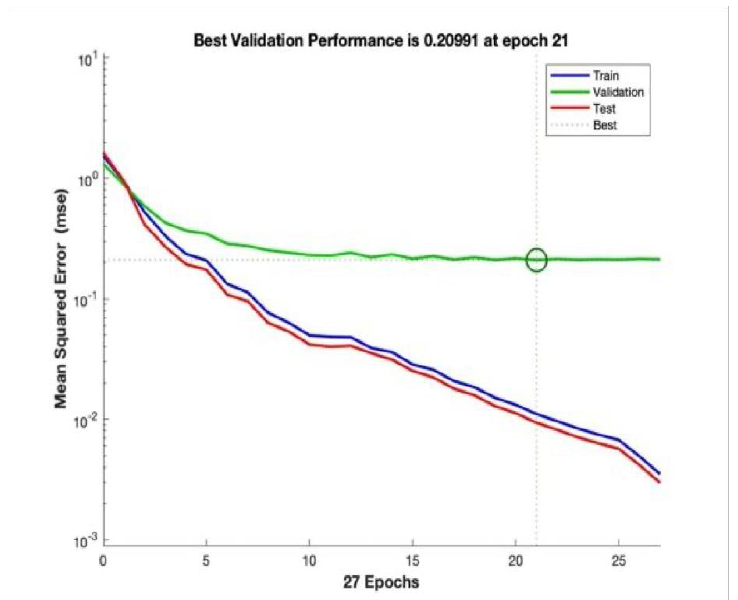
Figure 4: Classification Performance of SubB_6chan_3LRF BPN Classifier